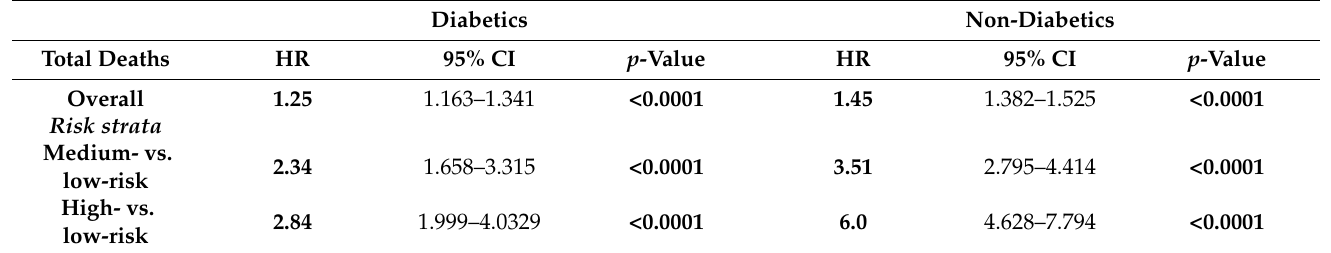
Table 5. The total all-cause death hazard ratios for C 2 HEST risk stratification in the diabetic